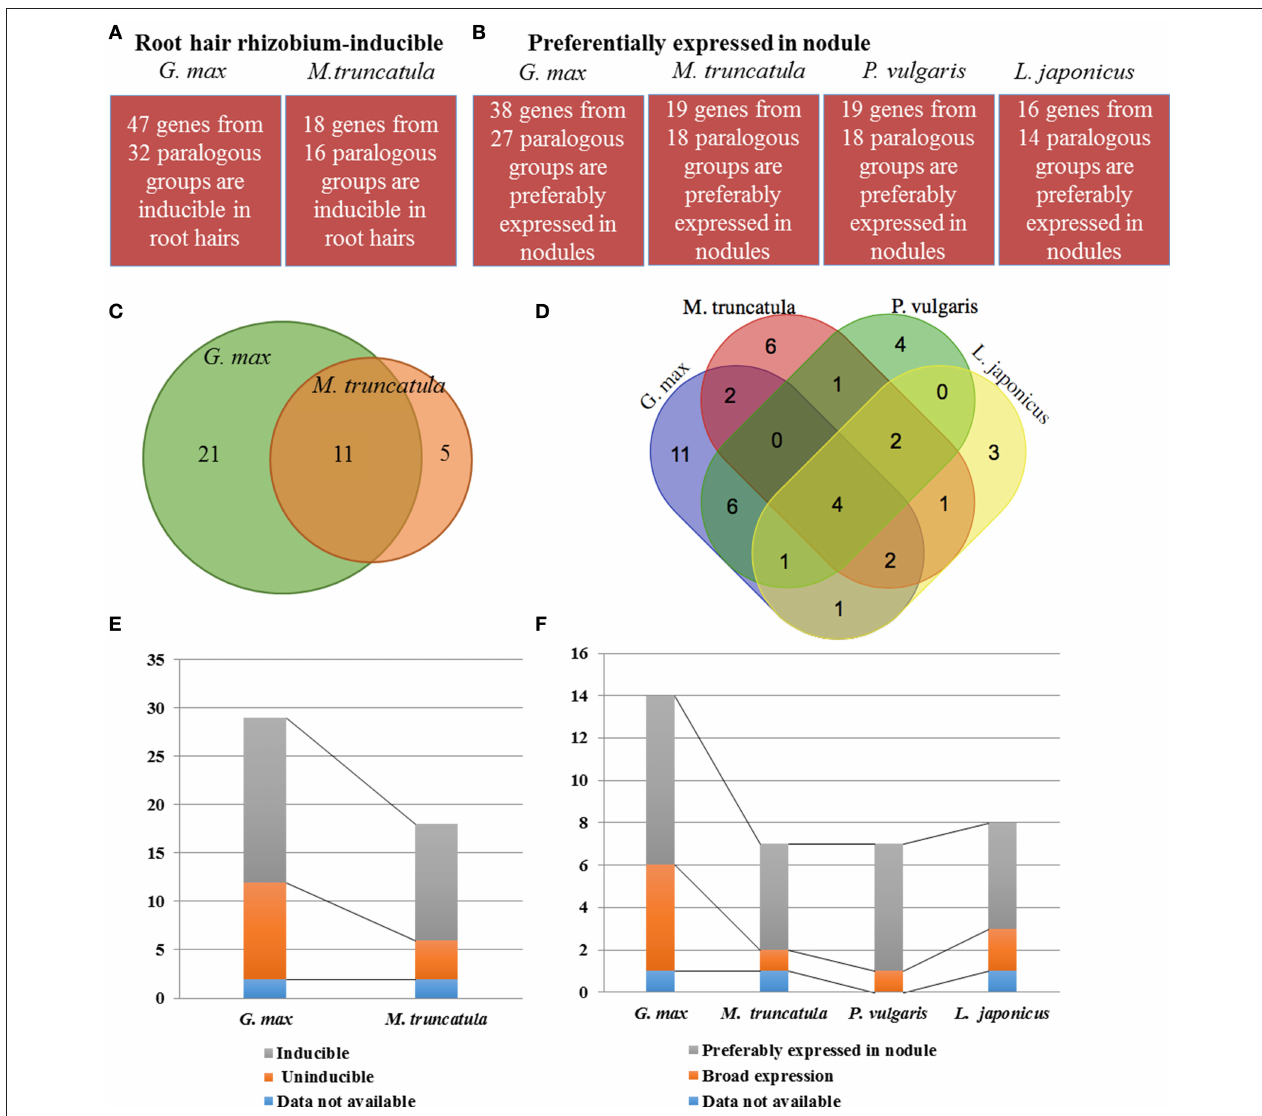
FIGURE 4 | Comparison of the expression profiles between G. max , M. truncatula , P. vulgaris, and L. japonicus orthologous genes and groups during the early (i.e., root hair response to rhizobia inoculation; A, C, E) and late stages of the nodulation process (i.e., preferential expression in mature nodules; B, D, F). (A) and (B) , numbers of G. max and M. truncatula genes and orthologous groups induced in root hairs upon rhizobia inoculation (A) and G. max , M. truncatula , P. vulgaris, and L. japonicus genes preferentially expressed in nodules ( B ; fold-change > 2; Supplemental Table 3 for details). (C) and (D) : Venn diagrams showing the overlaps between G. max and M. truncatula root hair inducible (C) and overlaps between G. max , M. truncatula , P. vulgaris, and L. japonicus nodule-specific (D) orthologous groups; (E) and (F) : Distribution of the number of G. max and M. truncatula genes which belong to the 11 root hair-inducible (E) and the number of G. max , M. truncatula , P. vulgaris, and L. japonicus genes which belong to four nodule preferential (F) orthologous groups, respectively, according to their expression